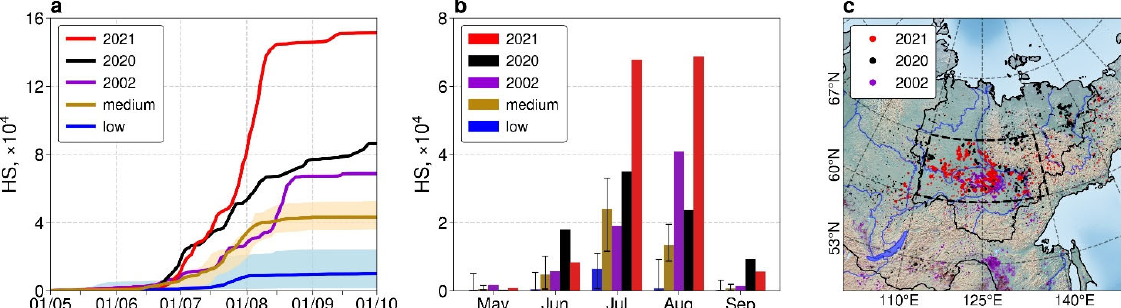
Figure 2. ( a ) Number of daily HS in Yakutia as a cumulative total; ( b ) monthly number of HS in Yakutia; ( c ) Map of HS in 2002 (purple), 2020 (black), and 2021 (red). Blue line ( a ) and bars ( b )—median values during years with low wildfire activity (2003–2011, 2015–2017), orange line ( a ) and bars ( b )—median values during years with moderate wildfire activity (2001, 2012–2014, 2018–2019). Shaded areas ( a ) and whiskers ( b ) indicate a 5–95 percentile range.